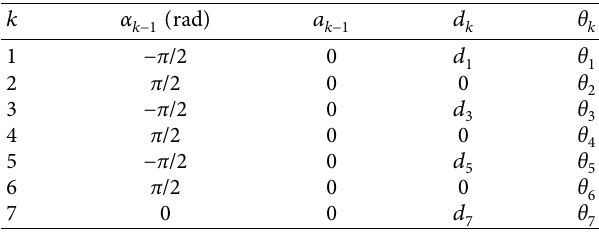
Figure 1: The simplified model of the space robot system. Table 1: The D-H parameters of the